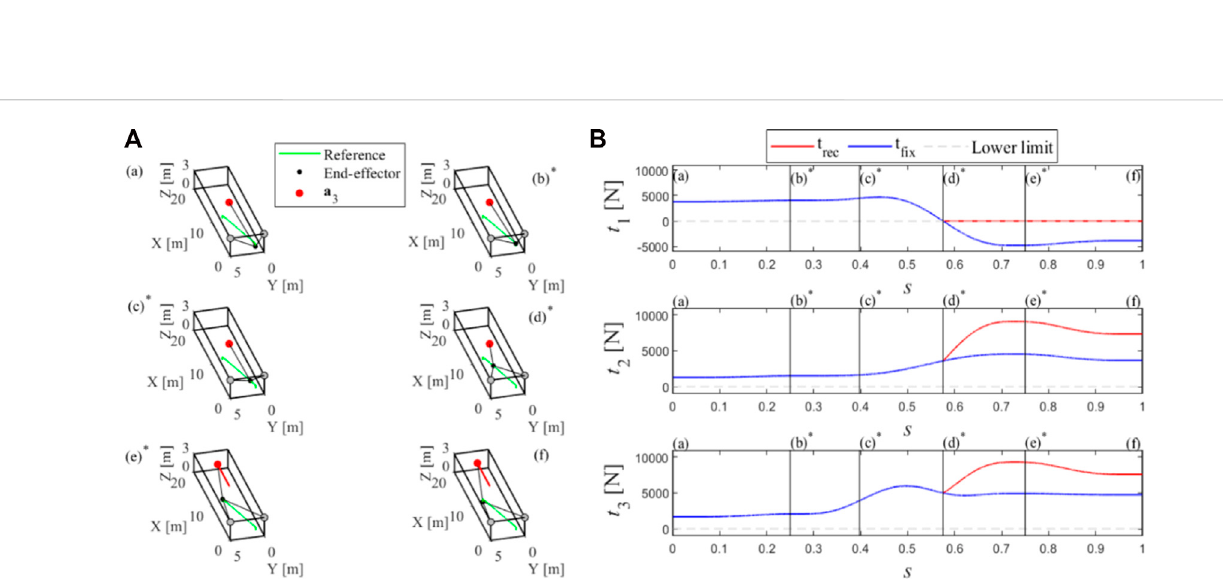
Frontiers in Robotics and